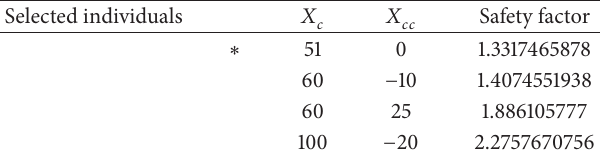
Figure 2: 2D potential failure surfaces.